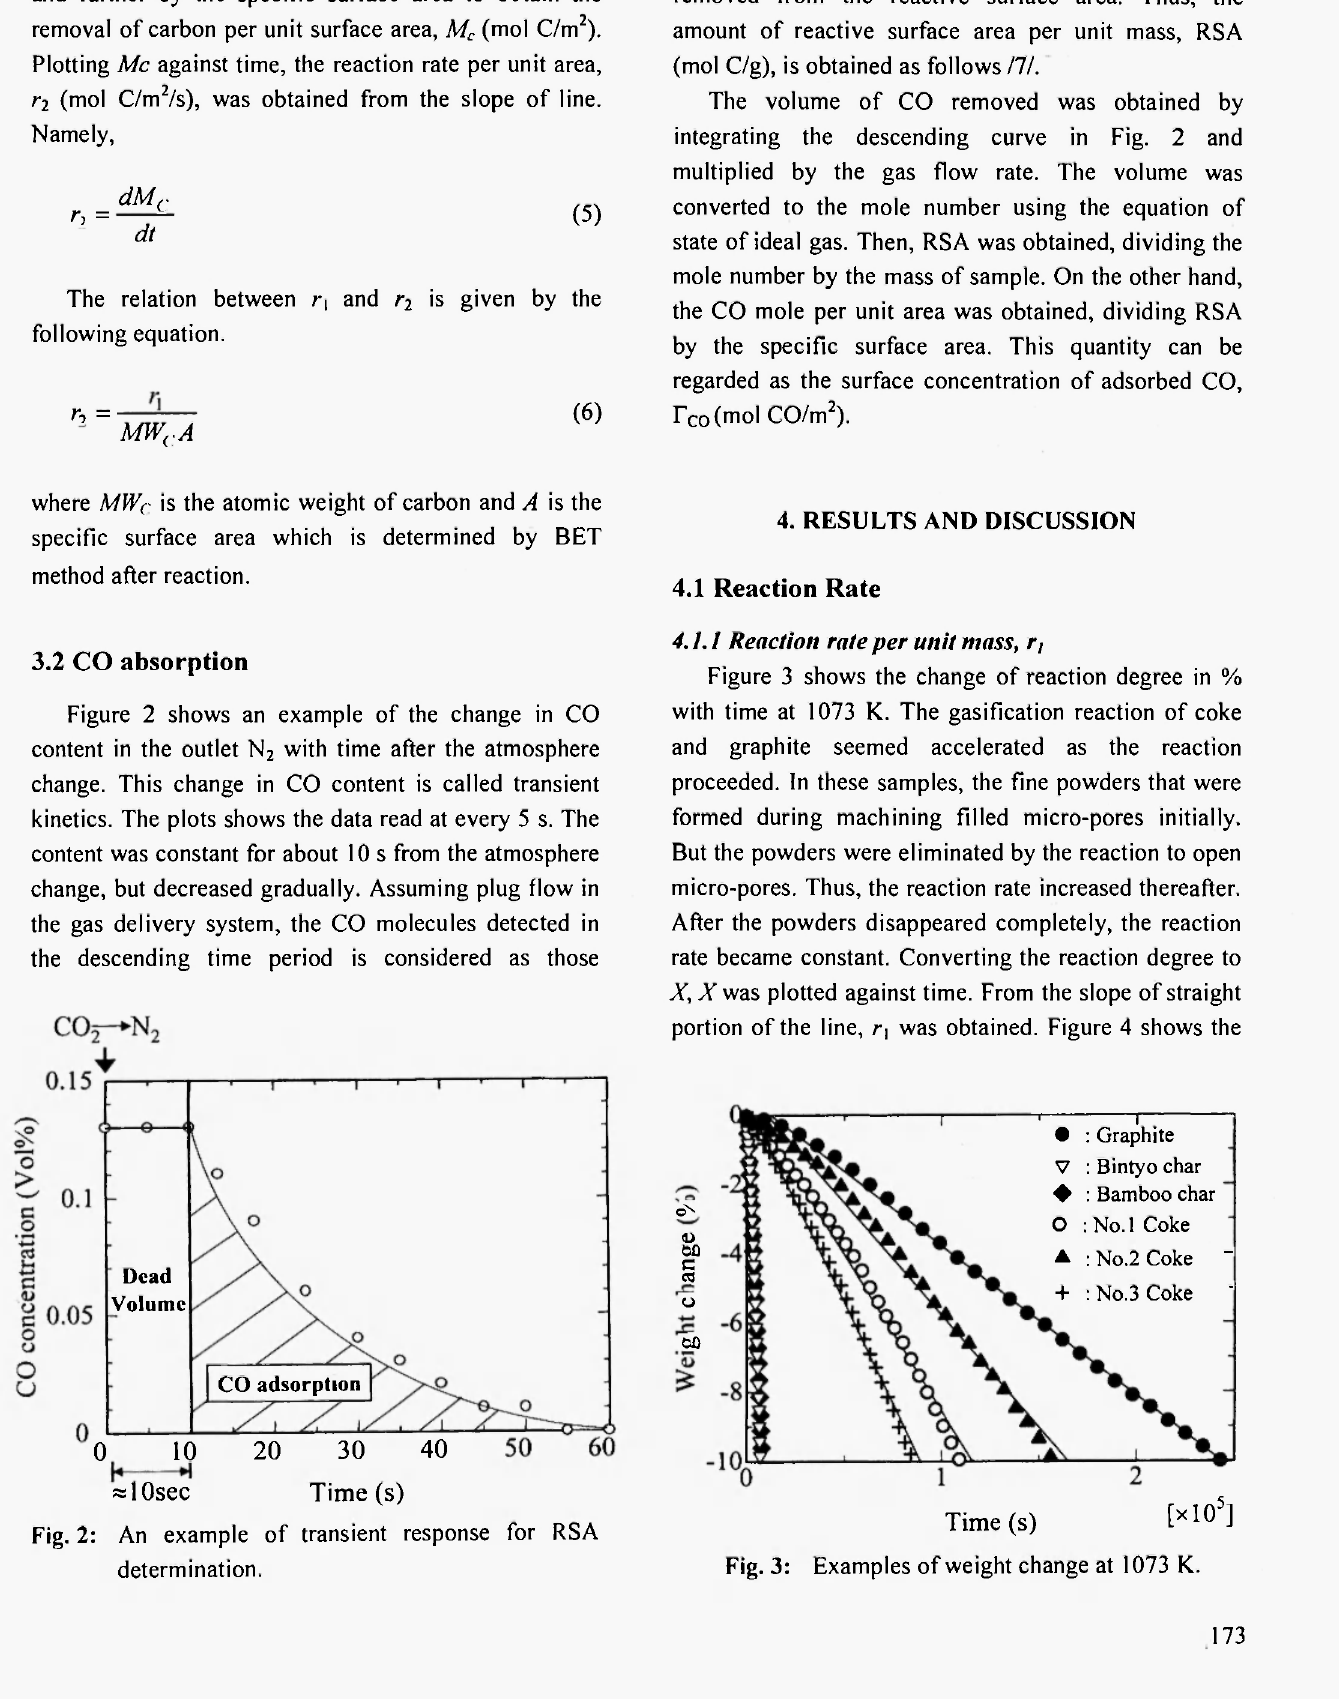
Fig. 2: An example of transient response for RSA determination. Fig. 3: Examples of weight change at 1073